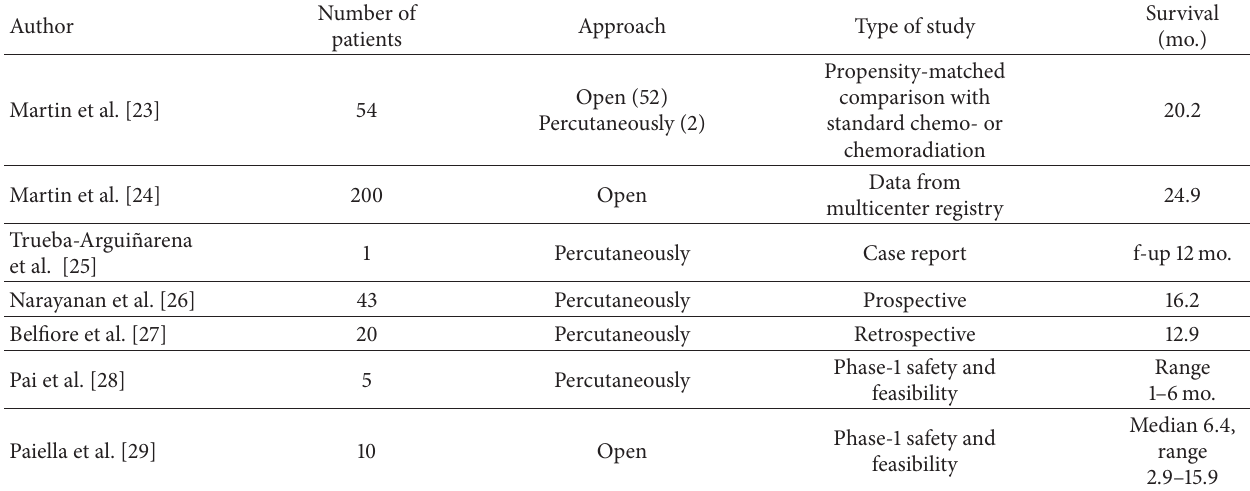
Table 1: Efficacy of IRE on